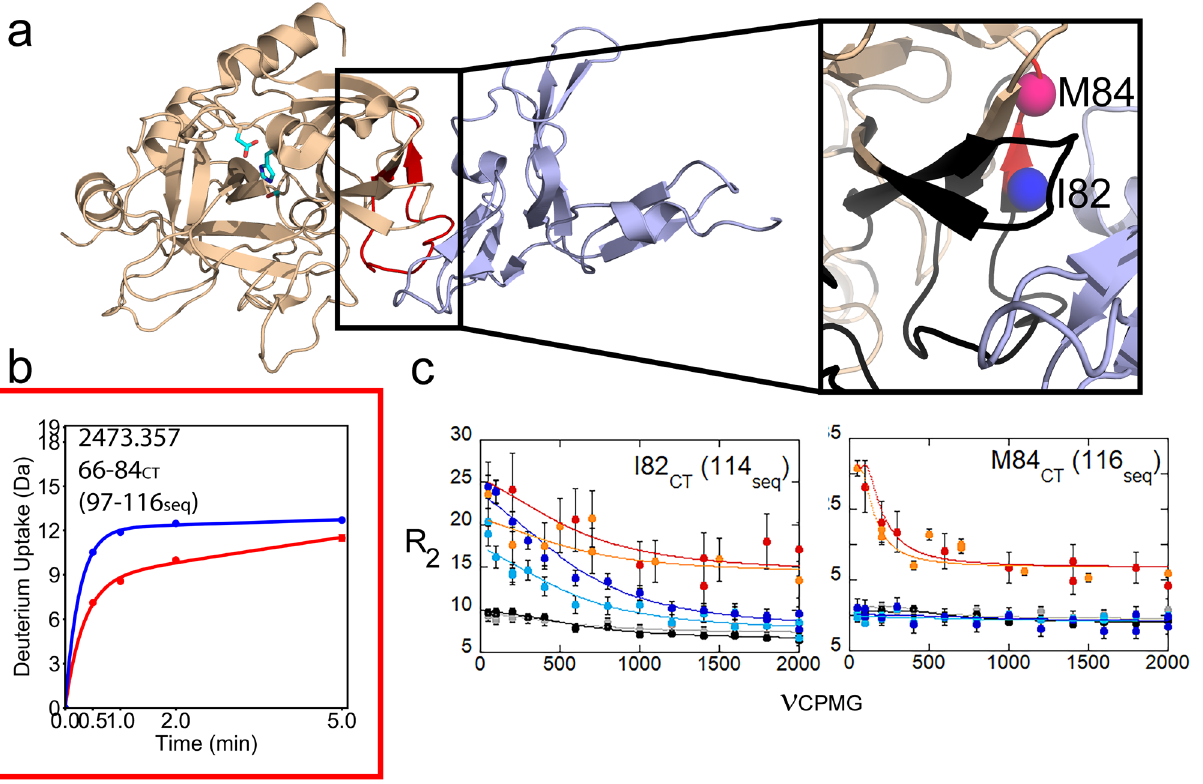
Figure 1. ( a ) Structure of thrombin (wheat) bound to TM456 (light blue) [PDB ID: 1DX5]. The side chains of the catalytic triad are shown as cyan sticks. Thrombin residues 66-84 CT (97-116seq) of the 70s CT loop are colored red (left). A close-up of the 30s CT and 70s CT loops (right) has residues missing from the thrombin-TM456 HSQC colored black, and the amides in this strand for which CPMG data was obtained as spheres. For all figures, pink spheres indicate residues with NH resonances experiencing increased μs-ms dynamics in thrombin-TM456 and blue spheres indicate residues with NH resonances experiencing reduced μs-ms dynamics as compared to apo- thrombin. ( b ) Deuterium uptake plots for the peptide spanning residues 66-84 CT (97-116seq; MH + 2473.357) in apo-thrombin (blue) compared to thrombin bound to TM456 (red). Error bars (standard deviation of three replicates) are shown. ( c ) CPMG plots for resonances corresponding to Ile 82 CT (112seq) and Met 84 CT (116seq). For all figures, the red and orange curves are from spectra collected on thrombin-TM456 at 800 MHz and 600 MHz respectively, the blue and cyan curves are from apo-thrombin at 800 MHz and 600 MHz respectively, and the black and grey curves are from PPACK-thrombin at 800 MHz and 600 MHz respectively. For all figures, molecular structures were produced in PyMol, deuterium uptake plots were produced in DECAv112 ( available at https:// github. com/ komiv eslab/ DECA), NMR spectra were plotted in SPARKY (available at https://